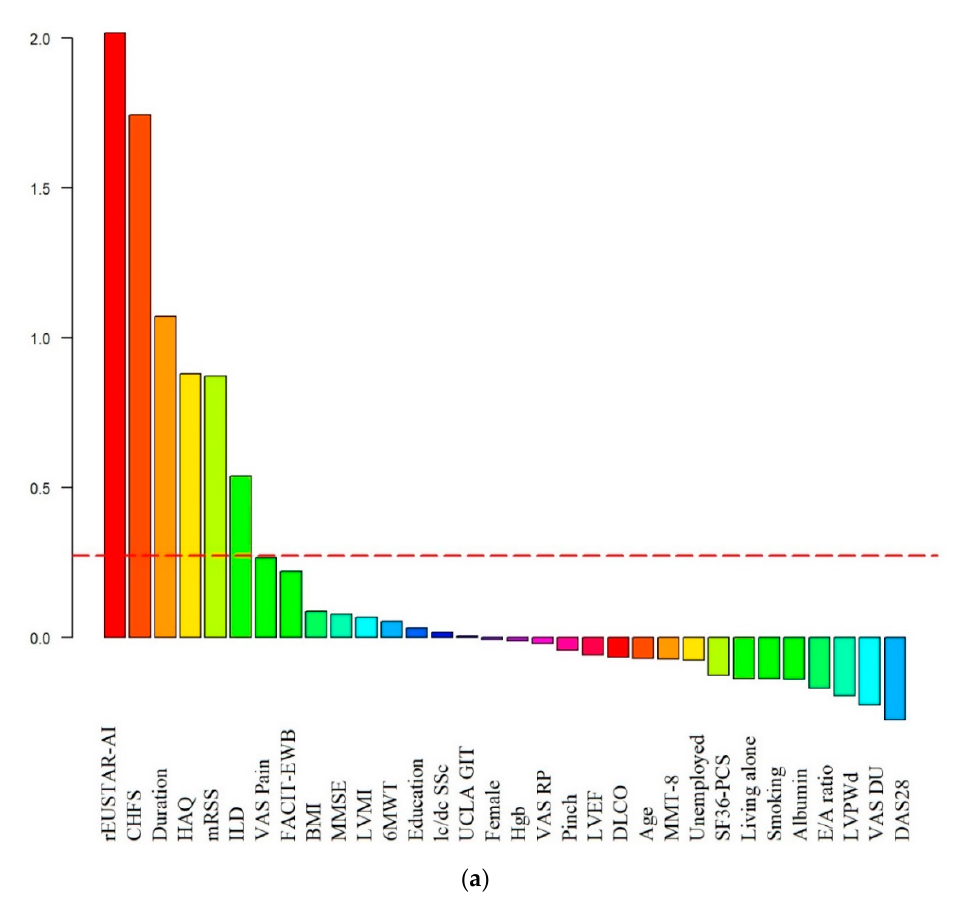
Figure 1. The discriminating ability of the Functional Assessment of Chronic Illness Therapy Fatigue Scale calculated with ROC curves, and sensitivity and specificity of the minimal clinically important difference values regarding the Visual Analogue Scale for Fatigue for ( a ) worsened, ( b ) improved; and the Short Form 36 Vitality scores for ( c ) worsened, ( d ) improved, based on data of the 144 followed patients with systemic sclerosis. ROC, receiver operating characteristic curve; AUC, Area Under the Curve.